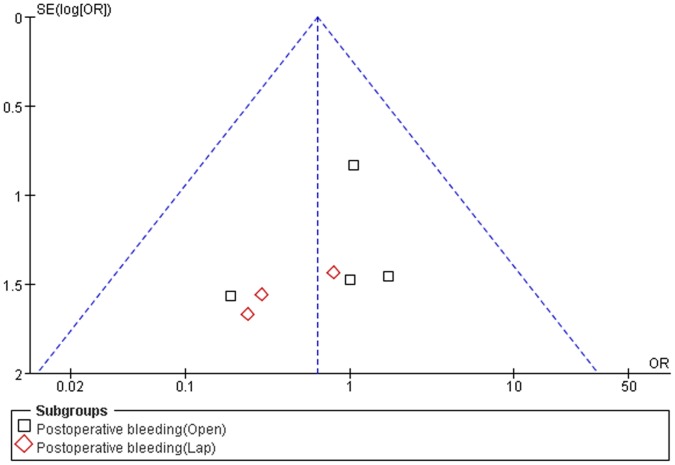
Funnel plots of postoperative bleeding.OR odds ratio; SE (log [OR]): standard error of the natural logarithm of the odds ratio.